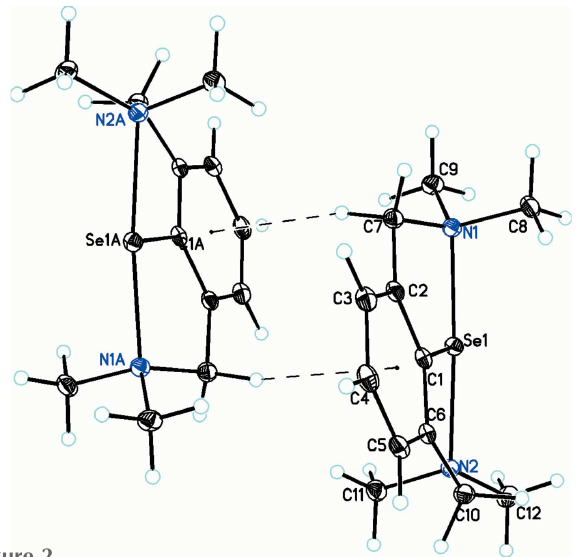
Figure 2 Diagram of a pair of cations showing the C—H (cid:2)(cid:2)(cid:2) (cid:2) interactions linking them into dimeric units. Atomic displacement parameters are at the 30% probability level.